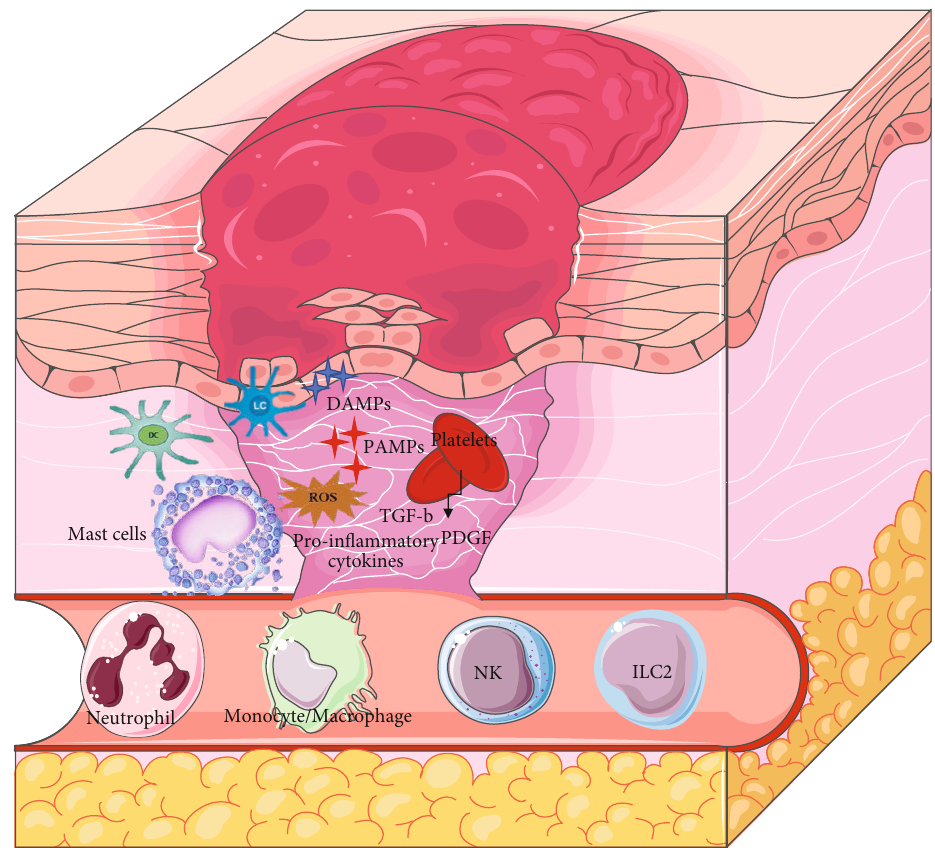
Figure 2: In fl ammatory phase of wound healing. Main innate cells that invade wound bed in response to local stimuli upon